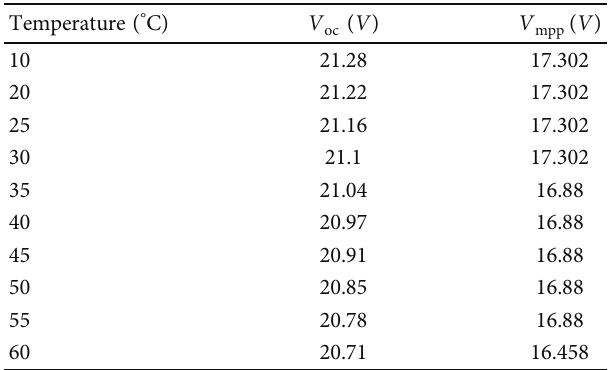
Figure 6: Variation of the MPPT voltage within the search space with variable temperature. Table 3: Validation of the search space region for MSX-60 W panel.